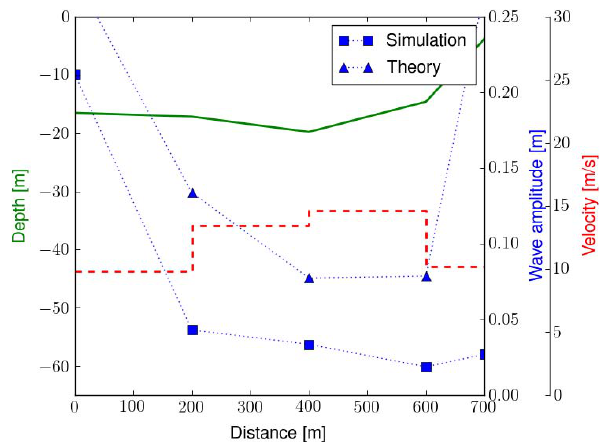
Fig. 6d. Wave propagation in south-east direction.